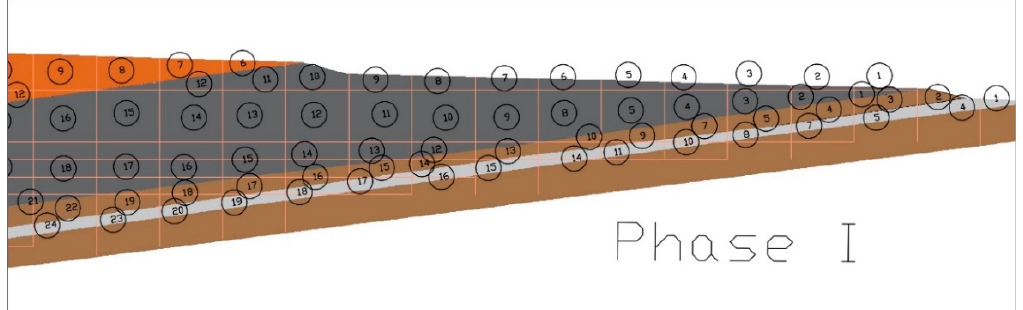
Figure 3. Sequencing of bloc extraction in the first exploitation phase. Two blocks with the same number mean that they are exploited at the same time.